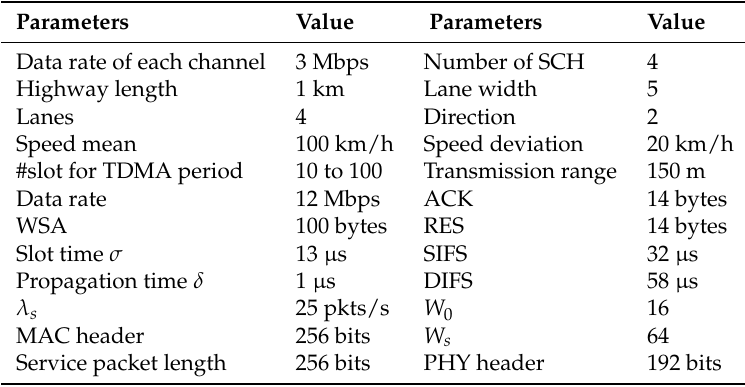
Table 3. Parameter